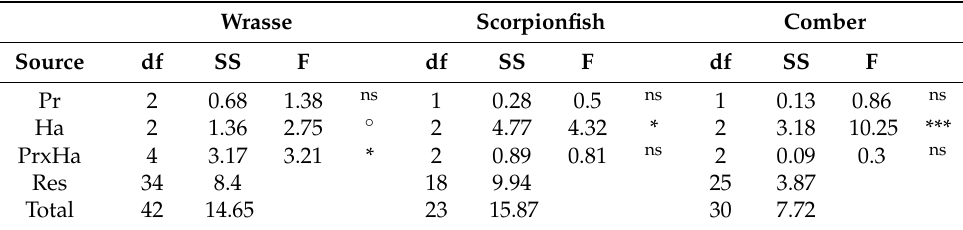
Figure 3. Habitat selection of prey and predators depending on predator–prey treatments. Selection Index (SI) mean values (95% CI) are presented in controls (shrub and forest, left and middle panel columns) and choice arena (right panel column), for wrasse (upper panel row), scorpionfish (middle panel row) and comber (lower panel row), when they are alone (predator–prey treatment W, S or C labelled on the right) or when prey and predator are together (SW or CW labelled on the right). In choice arena, SI < 0 means selection of forest part over shrub part, SI > 0 means the opposite. Results of post hoc pair-wise comparisons post hoc to ANOVA (Table 1) are reported using equal/unequal symbols or lowercase letters. Habitat selection holds if on average SI shrub = SI forest = 0 ≠ SI choice-arena . See Section 2 for more details. Table 1. PERMANOVA on Selection Index. For each species (the prey wrasse, the predator scorpi- onfish, the predator comber), comparison of the Selection Index (SI) between habitat treatment (Ha, 3 levels: Control Forest, Control Shrub and Choice Arena) and predator–prey treatments (Pr, 3 levels for the prey: the prey alone, the prey and the scorpionfish, the prey and the comber; 2 levels for each predator: the predator alone vs. the predator and the prey). ns not significant; ◦ p < 0.1; * p < 0.05; *** p < 0.001. See also Figure